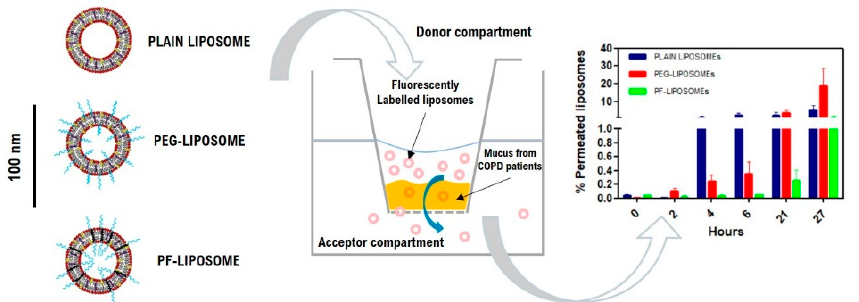
Figure 7. Experimental design to assess the mucopenetrative properties of plain-, PF127-, and PEG-liposomes, using the mucus of chronic obstructive pulmonary disease (COPD) patients. Reproduced with permission from [22] . Copyright © 2018 Elsevier.